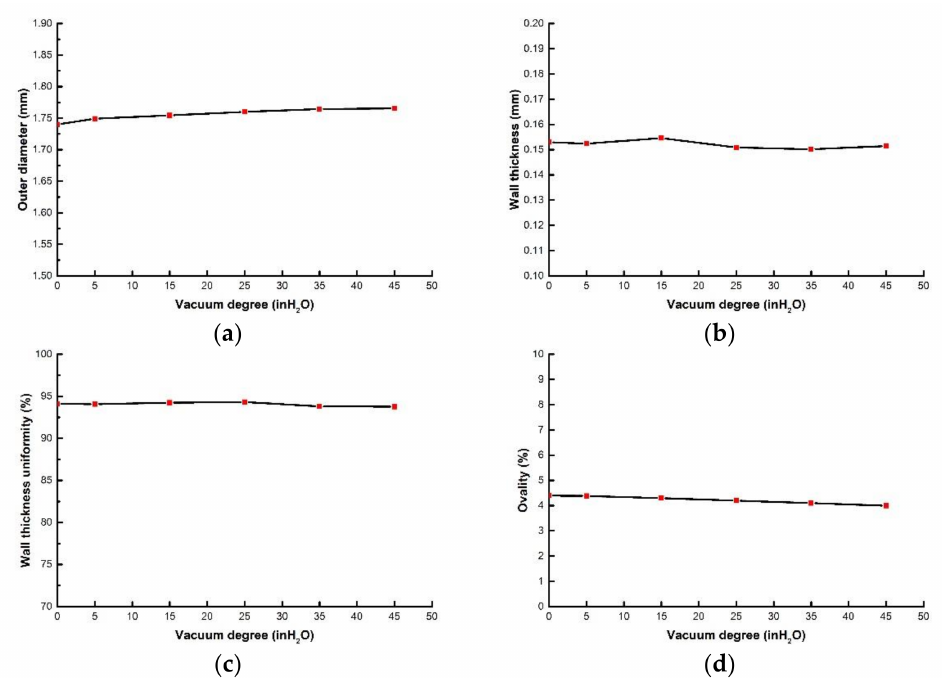
Figure 16. The relationships between evaluation index with vacuum degree: ( a ) The relationship between outer diameter with vacuum degree; ( b ) The relationship between wall thickness with vac- uum degree; ( c ) The relationship wall thickness uniformity with vacuum degree; ( d ) The relationship between ovality with vacuum